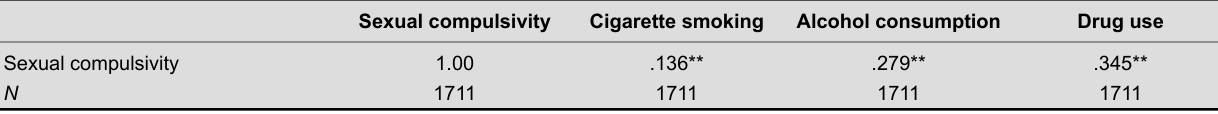
Sexual Compulsivity and Substance